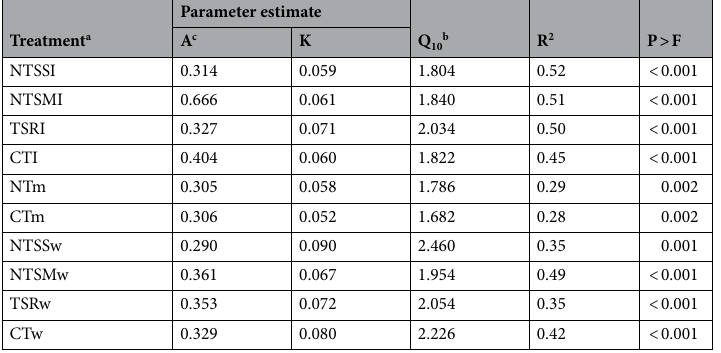
Table 1. Parameter estimates for the exponential relationship between soil CO 2 fluxes (F s , μmol m −2 s −1 ) and soil temperature (T s , °C) in the 0–10 cm depth across years by cropping treatment. F s = A × e KTs . a Descriptions of treatment abbreviations are in Table 4. b Q 10 : the rate of soil CO 2 fluxes change with each 10 °C increase in soil temperature, calculated as e KTs . c A and K are constants of the exponential equation.